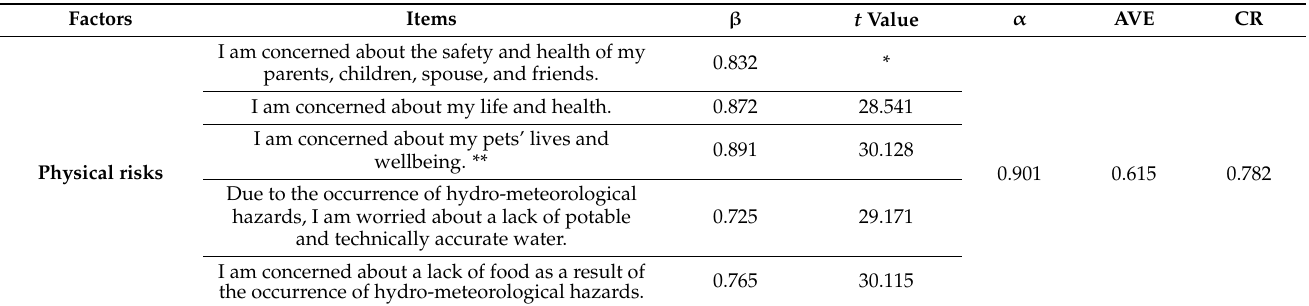
Table 2. CFA results for Objective factors